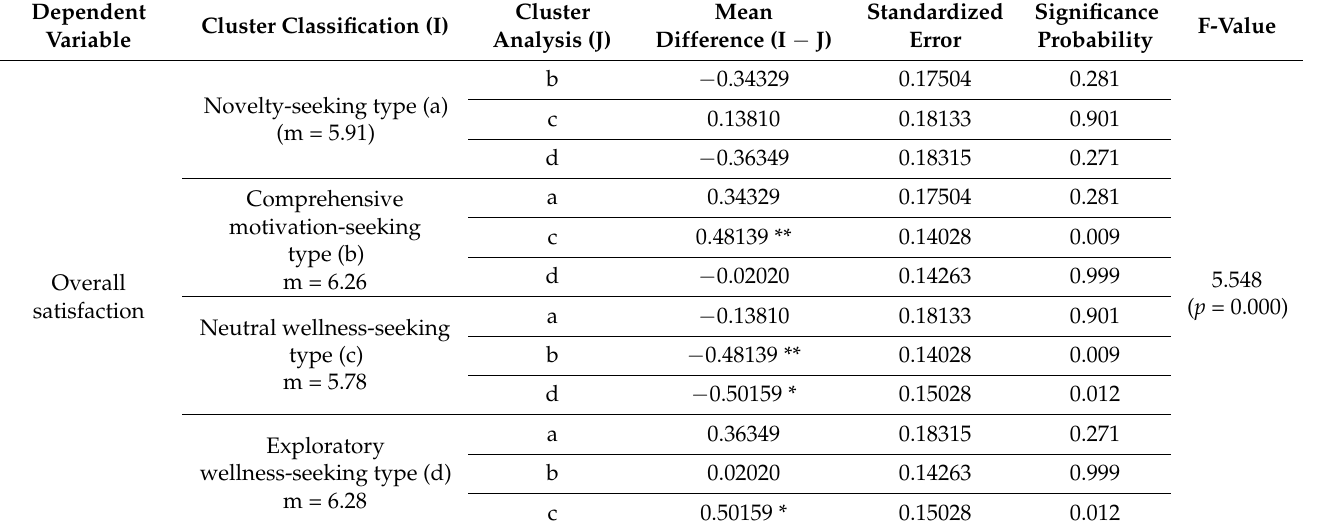
Table 13. Differences in the means of overall satisfaction among wellness tourism product partici- pant